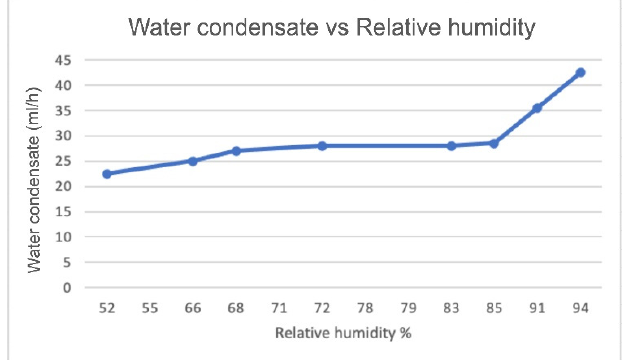
Figure 7. Amount of produced water (in mL/h) as a function of relative humidity considering an air flow rate of 0.0245 m 3 /s and I of 1.09 A for the experiment in actual weather conditions in Kuwait.